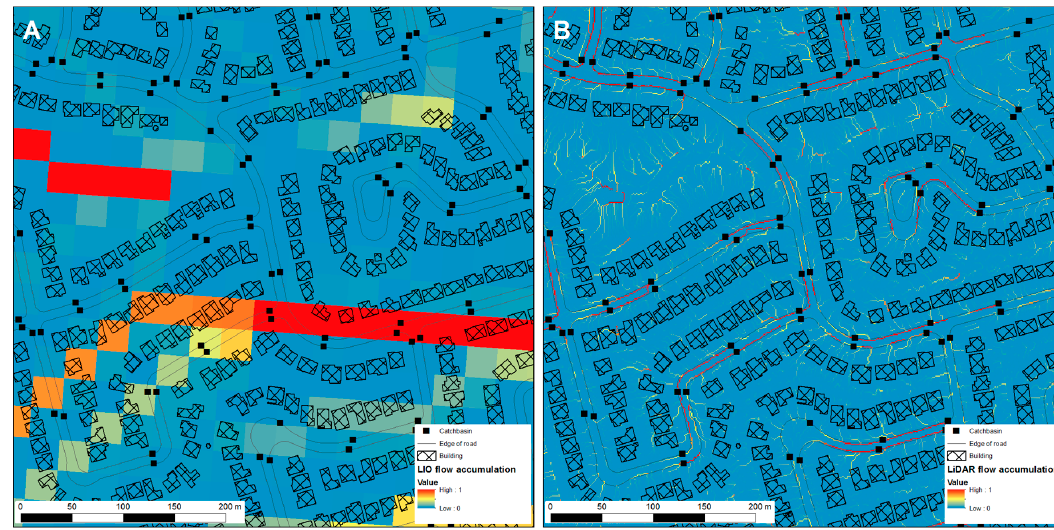
Figure 4. Flow accumulation (proportion) derived from a 20-m DEM (Panel ( A )). Flow accumulation (proportion) derived with a 1-m DEM (Panel ( B )).